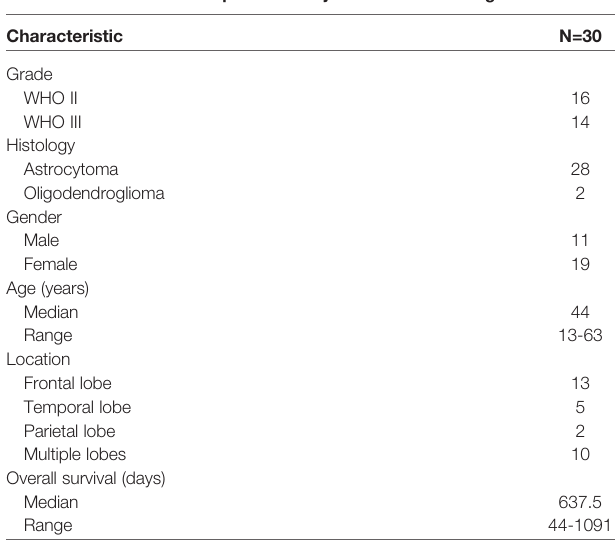
TABLE 1 | Information of participants in this